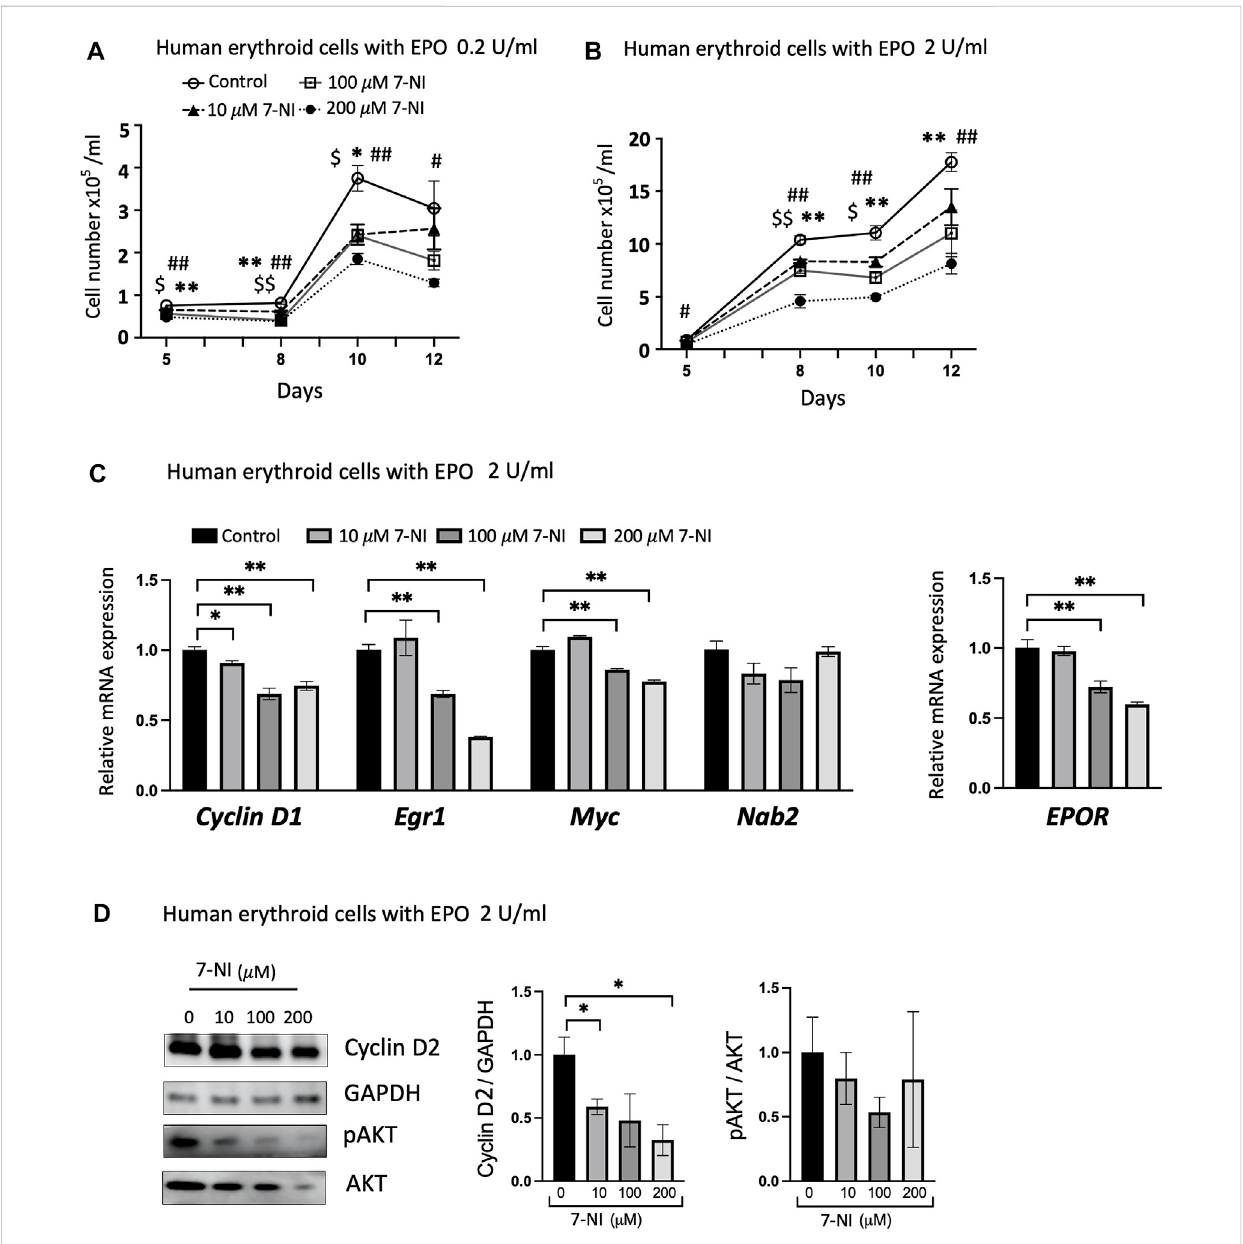
FIGURE 5 nNOS modulates proliferation of differentiating human erythroid progenitor cells. Treatment with nNOS inhibitor during EPO stimulated differentiation of primary human peripheral blood erythroid progenitor cells decreased proliferation and affected cell cycle related genes. (A,B) Growth curves of primary human erythroid progenitor cells stimulated with 0.2 U/mL (A) and 2 U/mL (B) EPO were treated with increasing doses of nNOS inhibitor 7-NI (0, 10, 100, 200 μ M) for 12 days ( n = 3/group; indicated are $, *, # p < 0.05, and $$, **, ## p < 0.01; $ means control vs. 10 μ M 7-NI, * meanscontrolvs.100 μ M7-NI,#means200 μ M7-NI). (C) Atday10ofculturewithEPOtreatment at2 U/mL, expression ofcellcycle-associatedgenes, Cyclin D1, Egr1, Myc and Nab2 , and EPOR was determined by quantitative RT-PCR ( n = 3/group). (D) Protein expression of Cyclin D2 with GAPDH as control and pAKT (Ser473)/AKT was determined by Western blotting ( n = 3 – 4/group). (Indicated are p p < 0.05, and pp p <